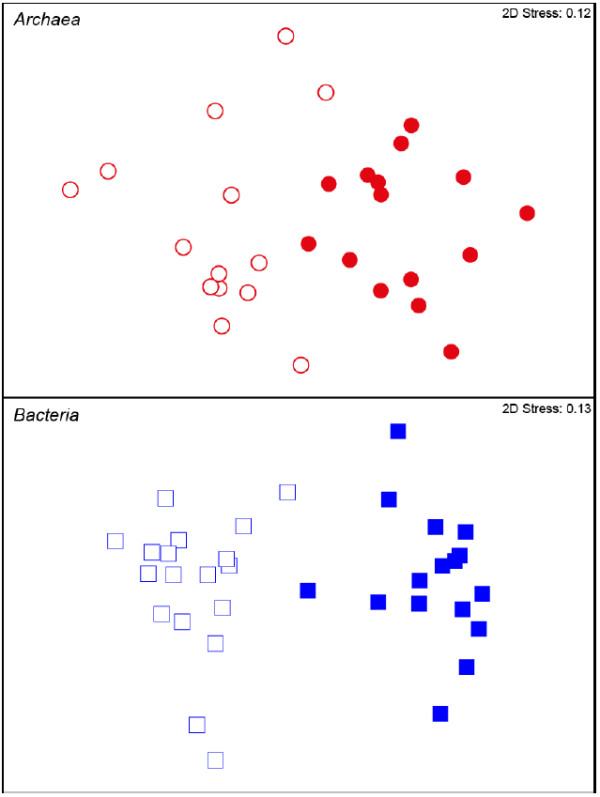
Nonmetric multidimensional scaling (MDS) ordination of the Bray-Curtis similarity coefficient for communities of archaea and bacteria in the Mahomet aquifer. Attached samples (filled markers) are of microbes that colonized in situ sampler sediment while suspended samples (open markers) were filtered from groundwater as it was pumped from the aquifer. For MDS analysis, sequences across all communities with 97% or greater sequence similarity were binned into operational taxonomic units (OTUs). The stress indicated in the upper right corner is the amount of strain imposed on the ordination when fitting it into two dimensions.